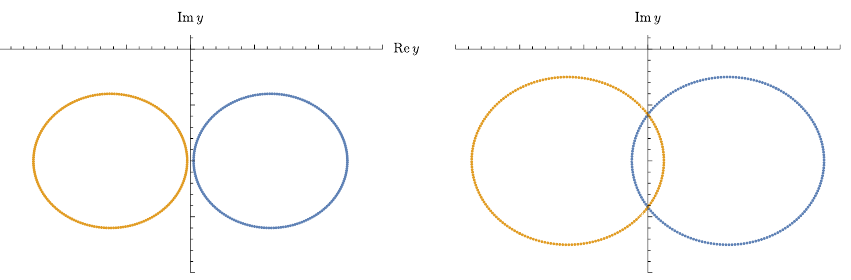
( x 2 ) of the spectral curve P 1 at complex x 2 = 1 | < | x 2 | (left panel) and | x 2 c 1